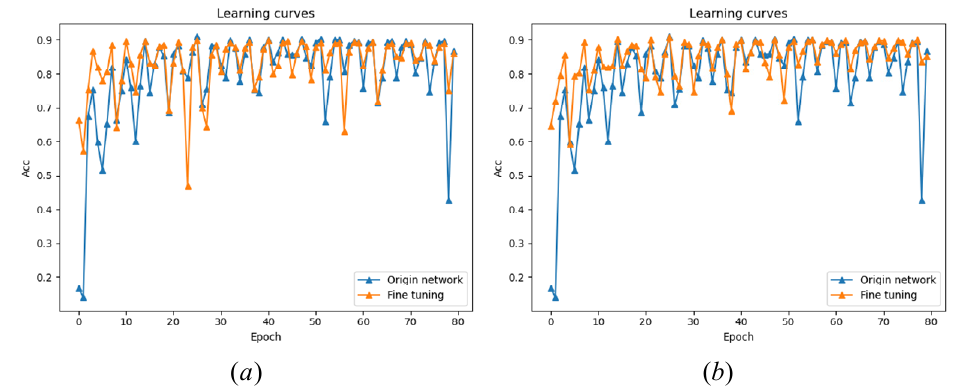
Figure 8. The effect of transfer learning on accuracy, they should be listed as: ( a ) shows horizontal